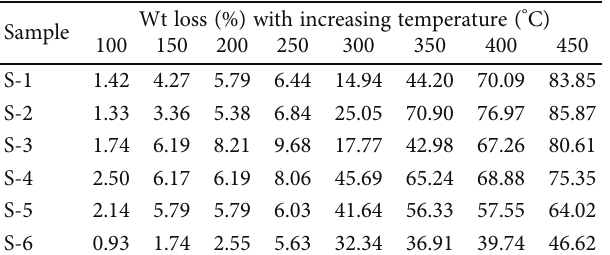
Figure 7: Variation in wt loss (%) of PVDF and PVDF-based NC FSs. Table 2: Fractional change in wt. loss (%) of synthesized PVDF and PVDF-based NC